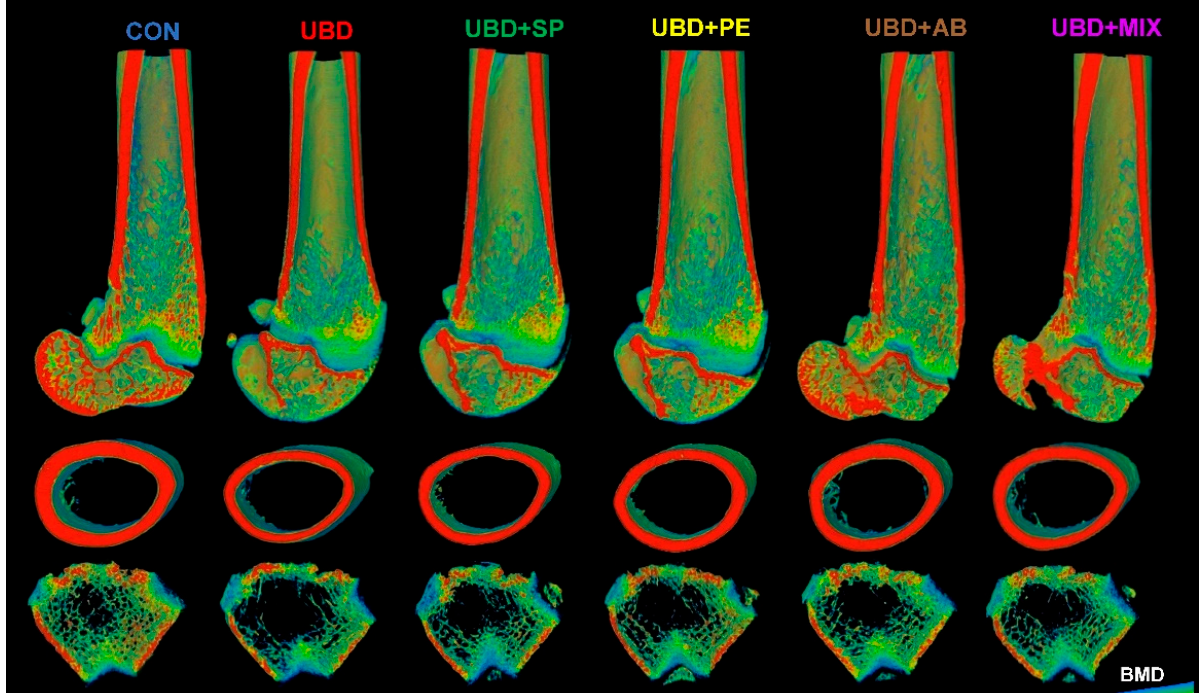
Figure 3. Three-dimensional reconstructions of femora scaled for mineral density using AMIRA software. Sagittal sections of the distal femora bone; Transverse sections of cortical area at mid-diaphysis; Transverse sections of trabecular bones at the distal epiphysis above the growth plate.